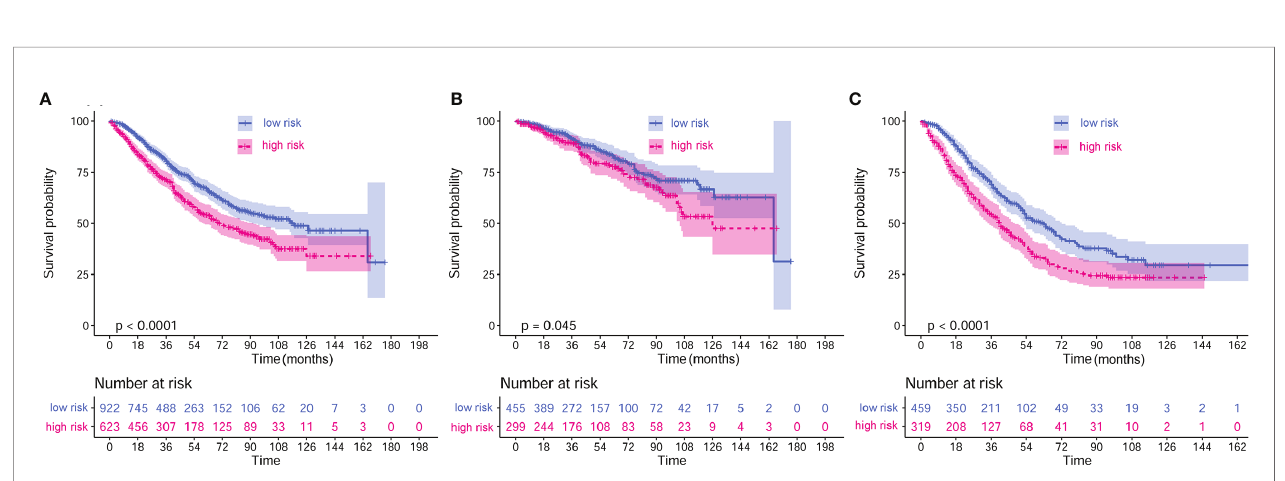
FIGURE 2 | Univariate analysis and multivariate analysis of risk factors for the prognosis in CRC. P value was based on Student ’ s t-test for continuous factors and Chi-square test (case number ≥ 5) or Fisher ’ s exact test (case number < 5) for categorical factors.